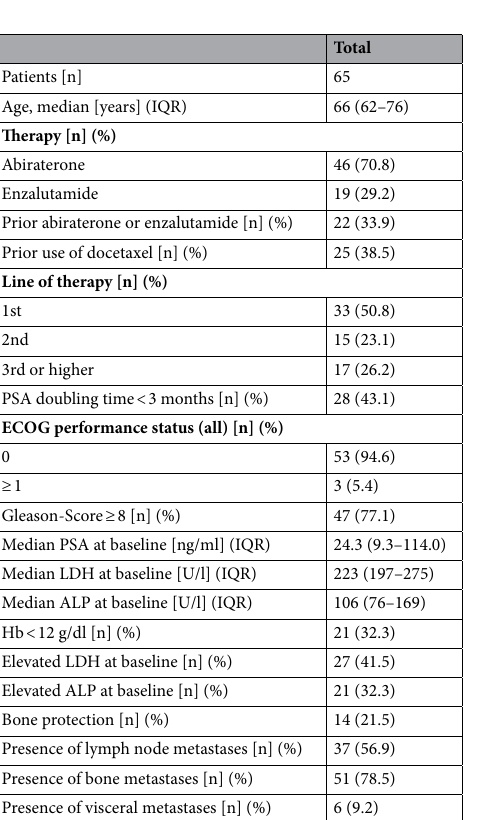
Table 1. Baseline characteristics of patients with mCRPC starting treatment with abiraterone or enzalutamide. ALP alkaline phosphatase, ECOG eastern co-operative oncology group, Hb hemoglobin, IQR interquartile range, LDH lactate dehydrogenase, PSA prostate specific